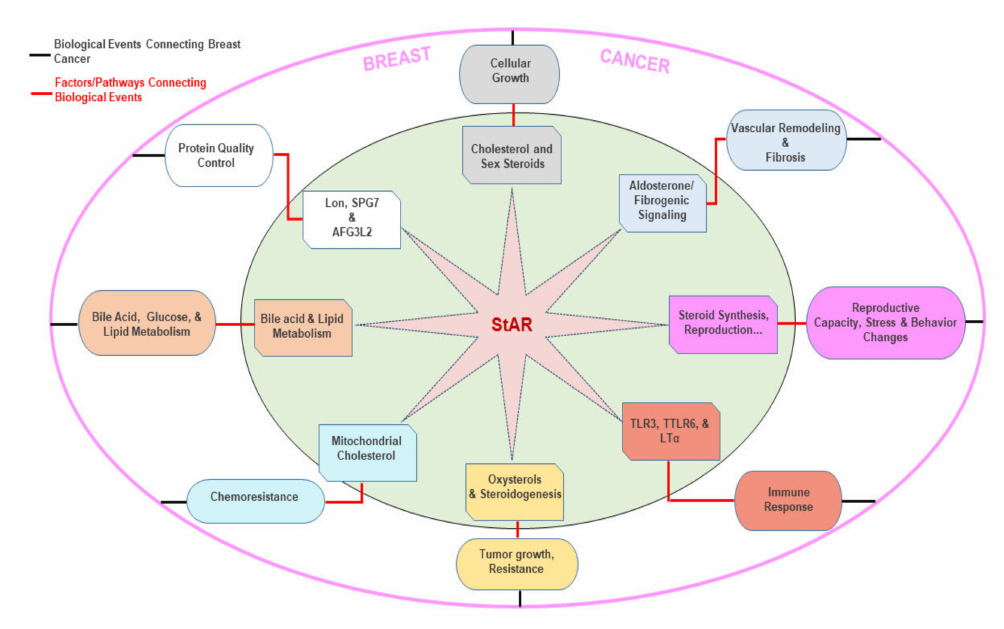
Figure 6. Multiple factors and/or signaling putatively influence StAR-mediated breast tumorigenesis. A hypothetical model illustrates association of a variety of factors and/or signaling pathways in growth and progression of BCs. The red line predicts factors/pathways that are connected with biological events. The black line, including StAR, with various events, predicts biological events that are connected with